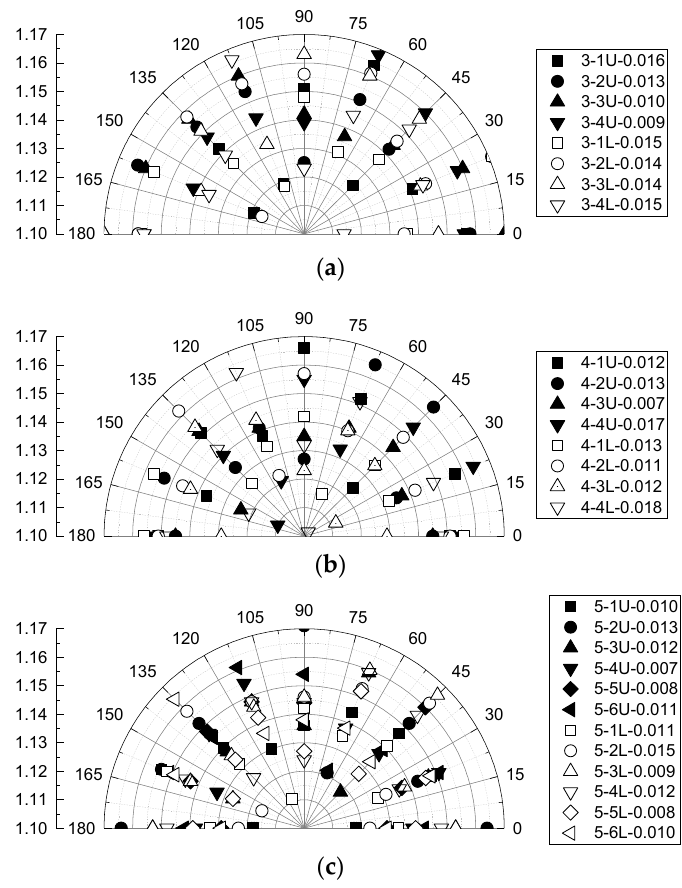
Figure 13. Fractal dimension of upper and lower surfaces. ( a ) Test 3; ( b ) Test 4; ( c ) Test 5.